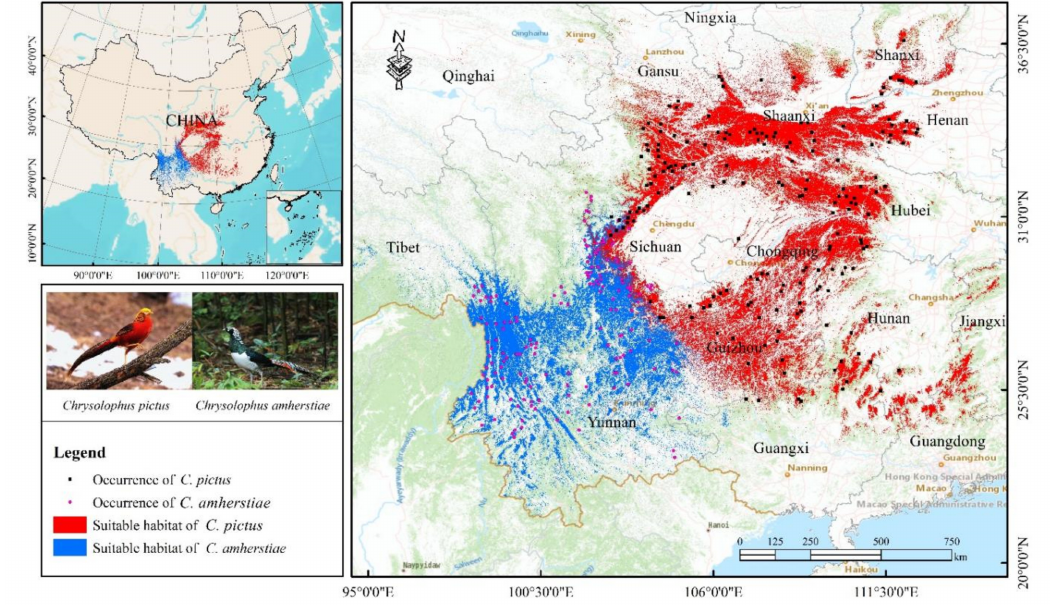
Figure 1. The potential suitable habitats of Chrysolophus spp.